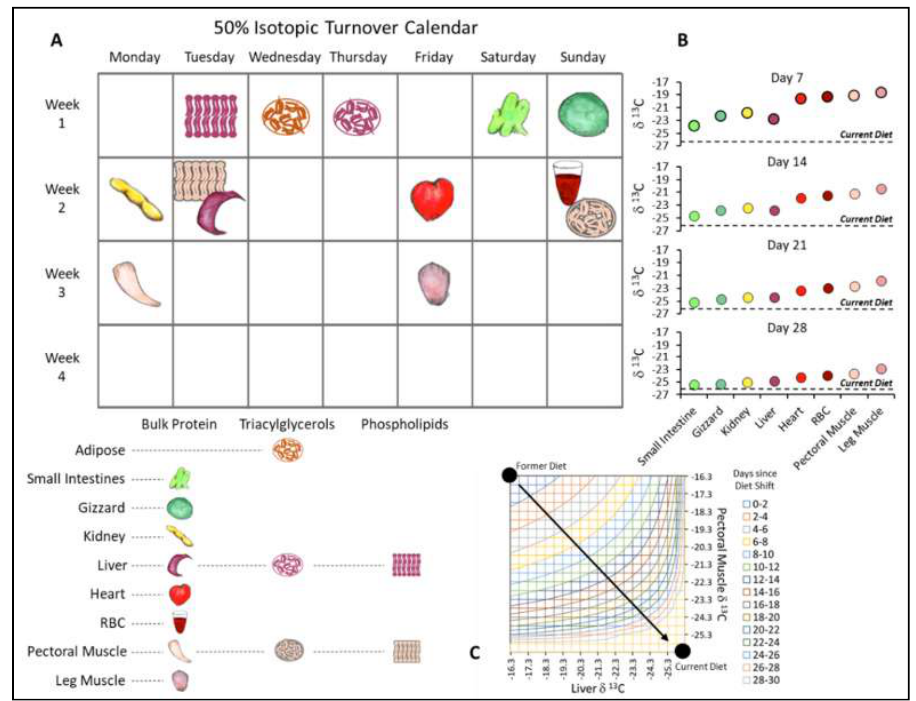
Figure 2. Differences in carbon turnover among zebra finch tissues and their application to isotopic clocks. The 13 C half-lives of different tissues ( A ) are widely distributed over the course of a month, with 50% of liver phospholipids replaced in less than two days and 50% of leg muscle protein replaced in twenty days. Differences in turnover among tissues leads, in turn, to differences in the amount of time required for tissue isotopic enrichment to reach equilibrium with current diet ( B ). Duration of time required for ca. 95% of the carbon to be replaced (and hence be effectively in equilibrium with current diet) can be roughly estimated as 4.3 half-life in days (e.g., small intestine = 4.3 × 6 days = 26 days). Inset ( C ) depicts an isotopic clock using liver and pectoral muscle turnover rates to estimate the timing of a hypothetical dietary shift from δ 13 C = −16.3‰ to δ 13 C = −26 .3‰ . For example, a measured value of δ 13 C = -20.3‰ for both liver and pectoral muscles would indicate that a diet shift occurred 8–10 days ago. Data are from [26], [69], and unpublished data (Carter).